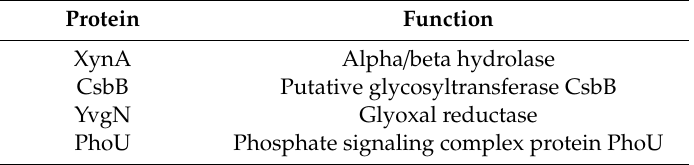
Table 2. Proteins commonly absent in L. iners genomes that are conserved in nine Lactobacillus